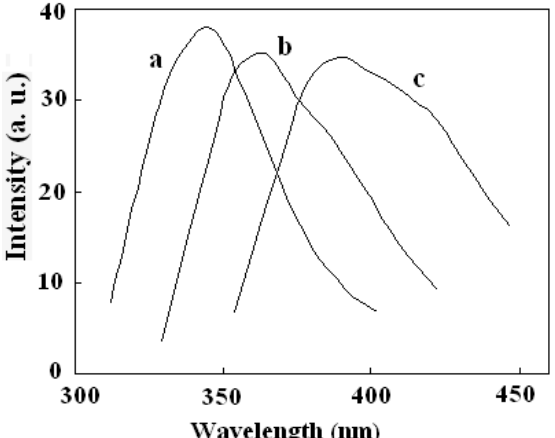
Figure 7. Fluorescence emission spectra of ( a ) DAPD; ( b ) DAPD-SMN and ( c ) DAPD-SMN-Cu 2+ The excitation wavelengths are 307 nm, 310 nm and 334 nm, respectively. C DAPD-SMN = 20 mg·L − 1 , C Cu2+ = 1 × 10 − 5 mol·L − 1 .